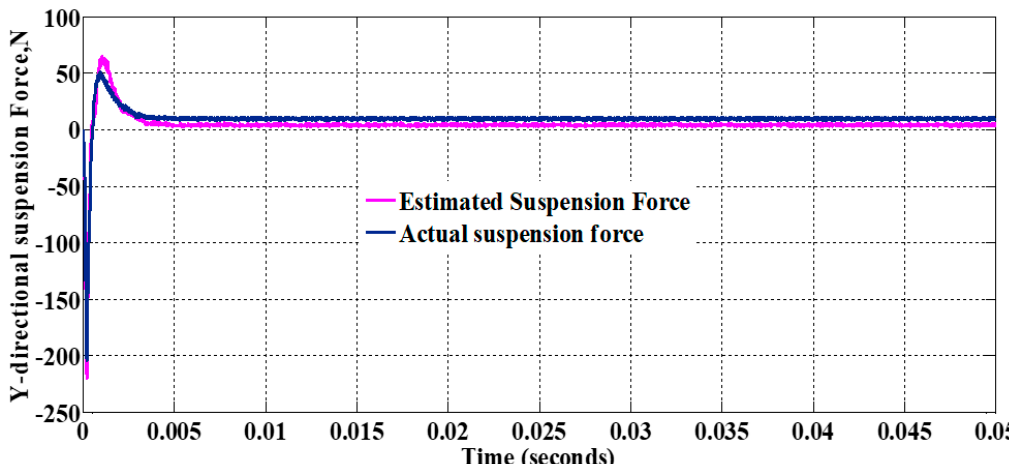
Figure 12. Estimated and actual Y-directional suspension forces.